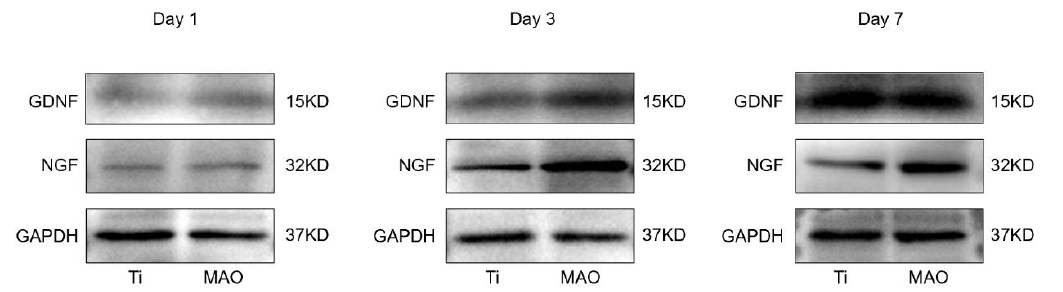
Figure 6. Protein expression level of NGF and GDNF in Schwann cells on days 1, 3 and 7 by western blot (mean ± SD, n = 6). GAPDH was used to normalize target proteins. Compared with the control group, the protein expression of NGF and GDNF was up-regulated, especially NGF, in the MAO group on day 3 and day 7.